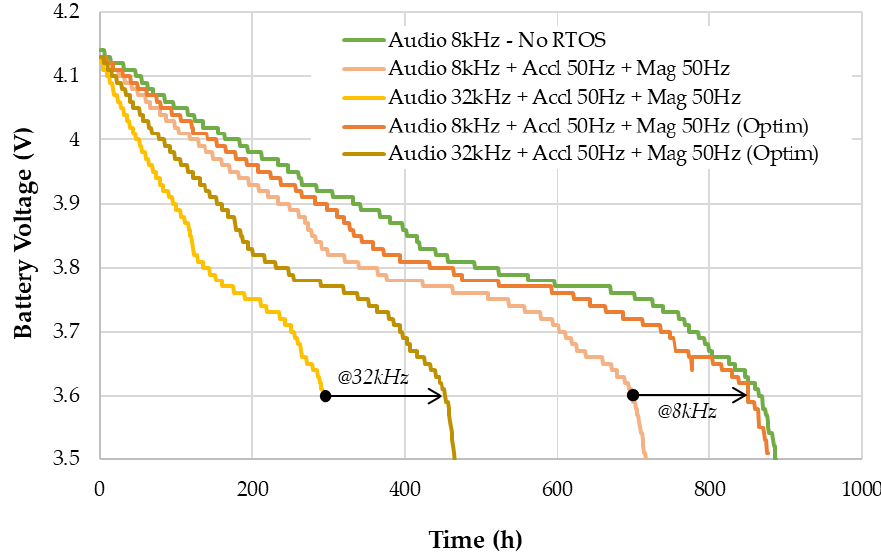
Figure 19. Battery voltage level over time during continuous recording (logger autonomy).